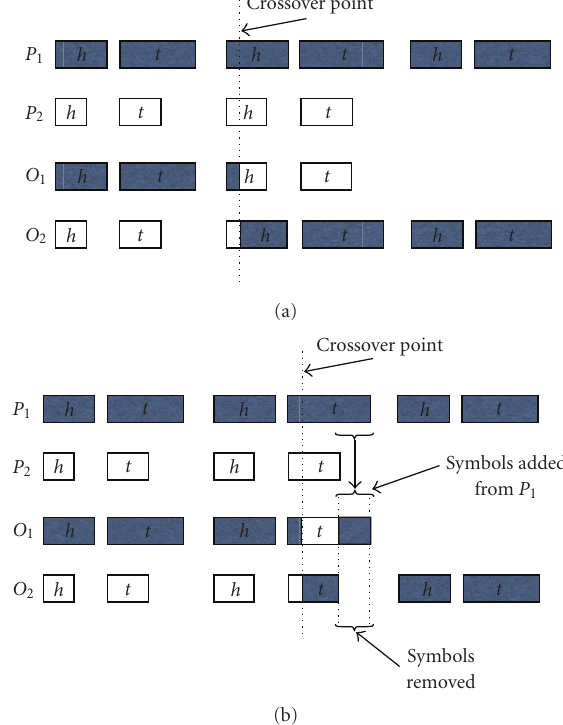
Figure 2: One-point recombination of two chromosomes, P 1 and P 2 , containing 3 and 2 genes, respectively; h and t denote the head and tail portions of each gene, respectively. In Figure 2(a) the crossover point locates in the head of a gene. In Figure 2(b) the crossover point locates in the tail of a